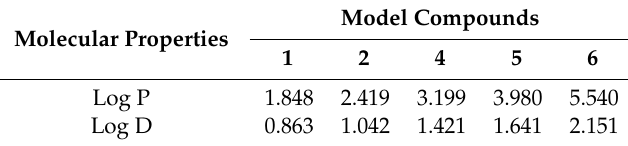
Table 6. Calculated log P and log D of 1 and esters 2 and 4-6 by ADMETlab [28]. Molecular